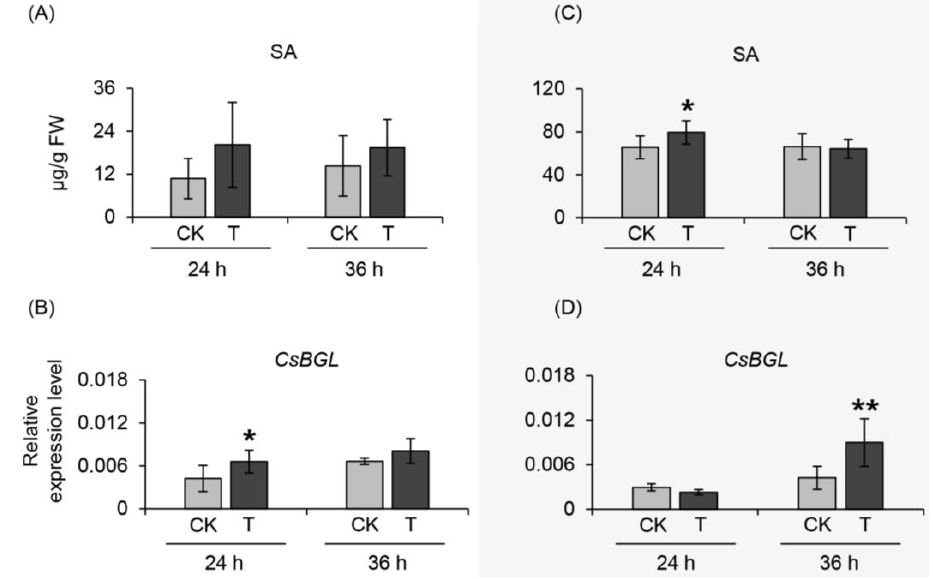
Figure 6. Changes in phytohormones content and expression levels of resistant related genes under α -farnesene in different treatment time, 24 h and 36 h. ( A , B ) All of the tea samples were collected in September 2018; ( C , D ) All of the tea samples were collected in June 2019. CK, dichloromethane (CH 2 Cl 2 ) treatment collected in different treatment time. T, α -farnesene dissolving in CH 2 Cl 2 treatment collected in different treatment time. Significant differences between control and treatment at the same treatment time are indicated (* p ≤ 0.05, and ** p ≤ 0.01). SA, salicylic acid; BGL , β -1, 3-glucanase ; FW, fresh weight.